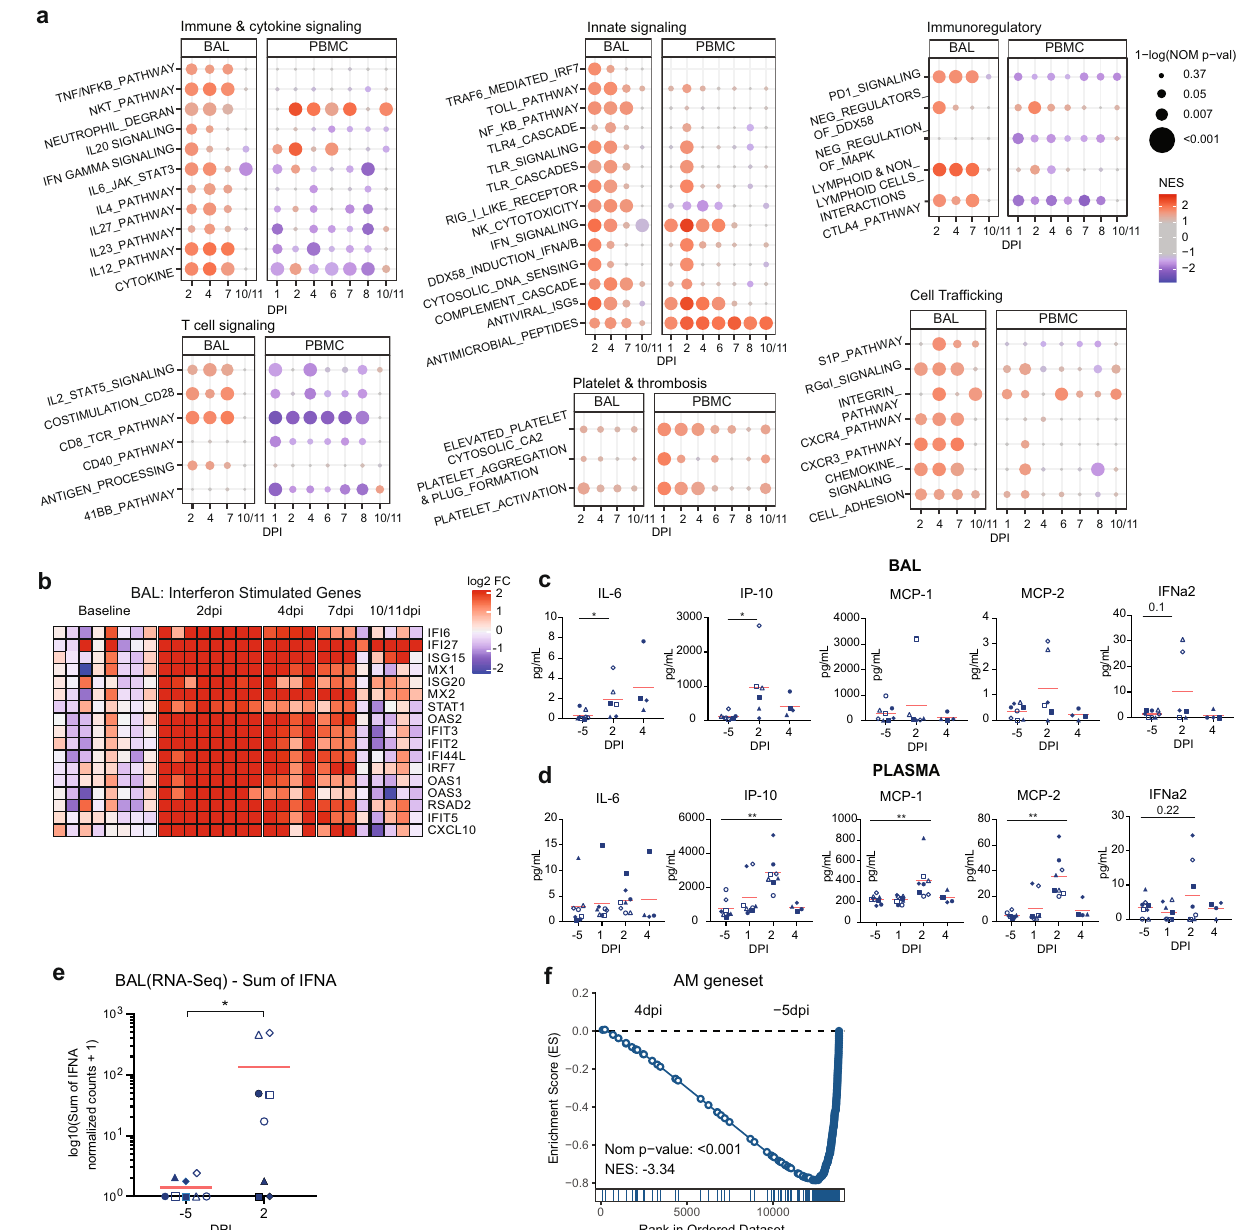
− 5dpisamples. c Cytokinesevaluation(Mesoscale)inBALF p valuesfor2dpivs. − 5 dpi: IL6=0.02 and IP-10=0.03 and d Plasma; only signi fi cant cytokines are shown ( p values for 2dpi vs. − 5 dpi: IP-10=0.008, MCP-1=0.008, MCP-2=0.004). e Sum of normalized expression of all IFNA genes in BAL. * p value=0.04. f GSEA enrich- ment plot showing negative enrichment for AM gene signature (derived from SingleR)whencomparingbulkBALRNA-Seqsamplesfrom4dpito − 5dpi(Nominal p value=0). The red bar represents the mean. Statistical analysis for ( c ) – ( e ) was performed using one-tailed Wilcoxon signed-rank test in R v4.2.2 comparing each timepoint to − 5dpi. * p value <0.05,** p value <0.01.Source data( c – e )are provided as a Source Data fi